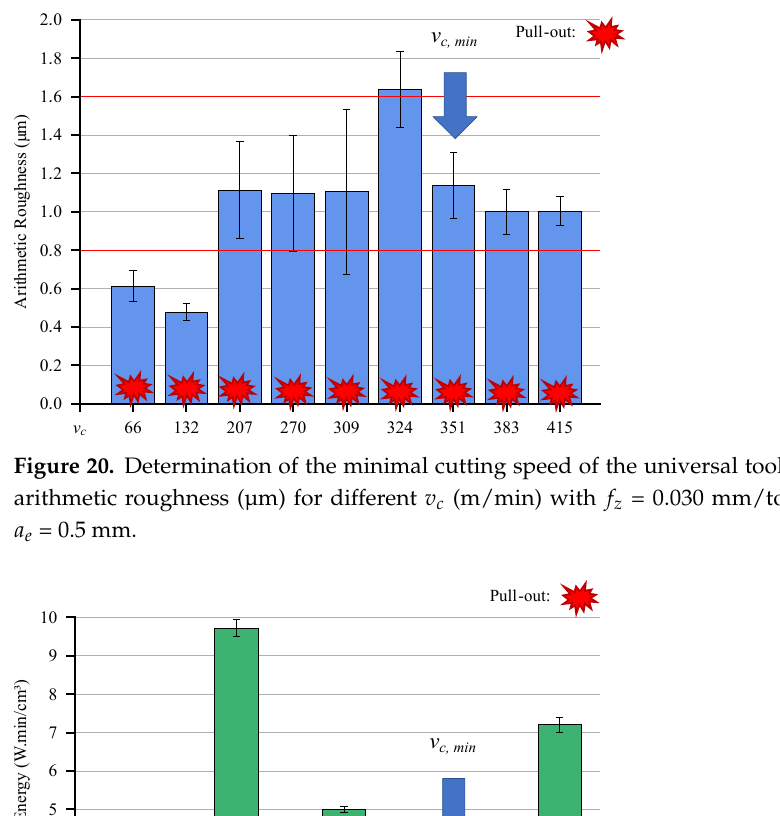
Figure 20. The selected minimal cutting speed is also higher than the cutting speed of the reference point. This is the result of the standard method, which first tests a reference point before selecting the minimal cutting speed. However, even with a higher cutting speed for the qualification test, the universal tool produced a surface topography with material pull-out. The conclusions are then the same.